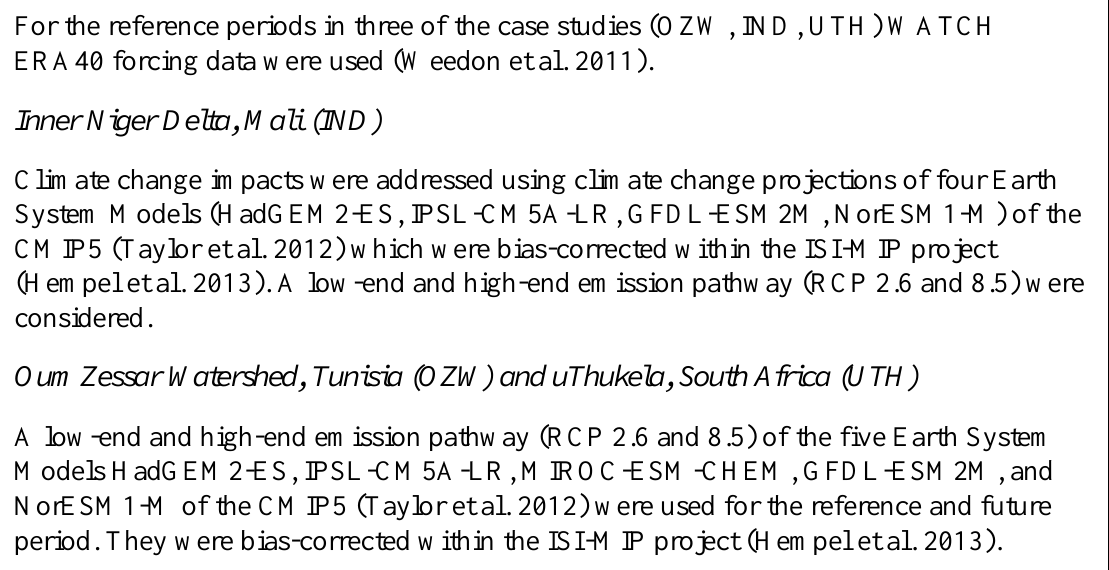
Box A1.1: Description of climate input data used in scenario assessments For the reference periods in three of the case studies (OZW, IND, UTH) WATCH ERA40 forcing data were used (Weedon et al.